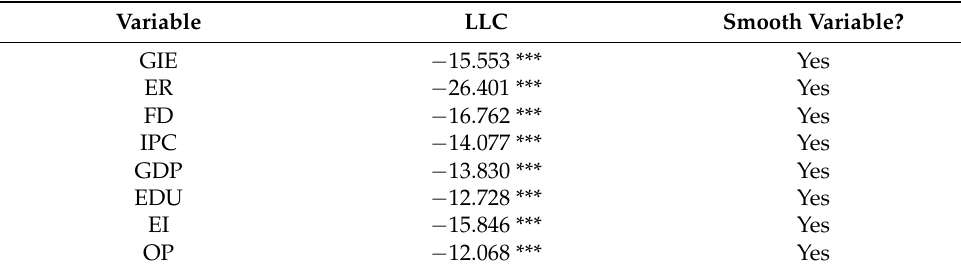
Table 4. Panel unit root test